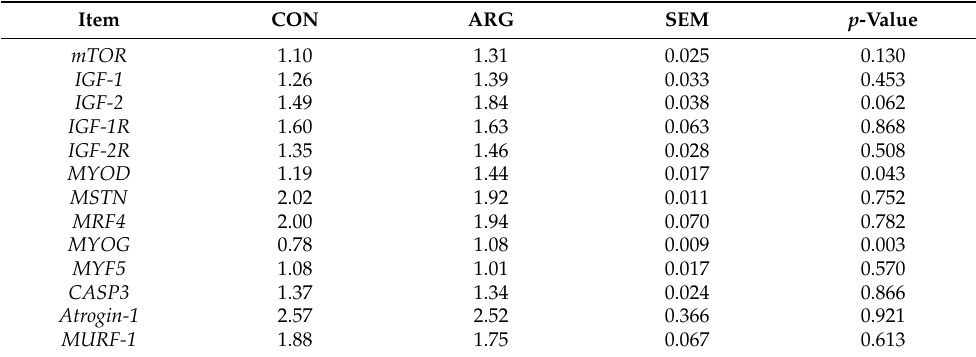
Table 6. Fold change between diets with 1.0% L-arginine (ARG) and control (CON) fed to sows ( n = 23) from 85 days of gestation on the relative expression of Longissimus dorsi genes in piglets.